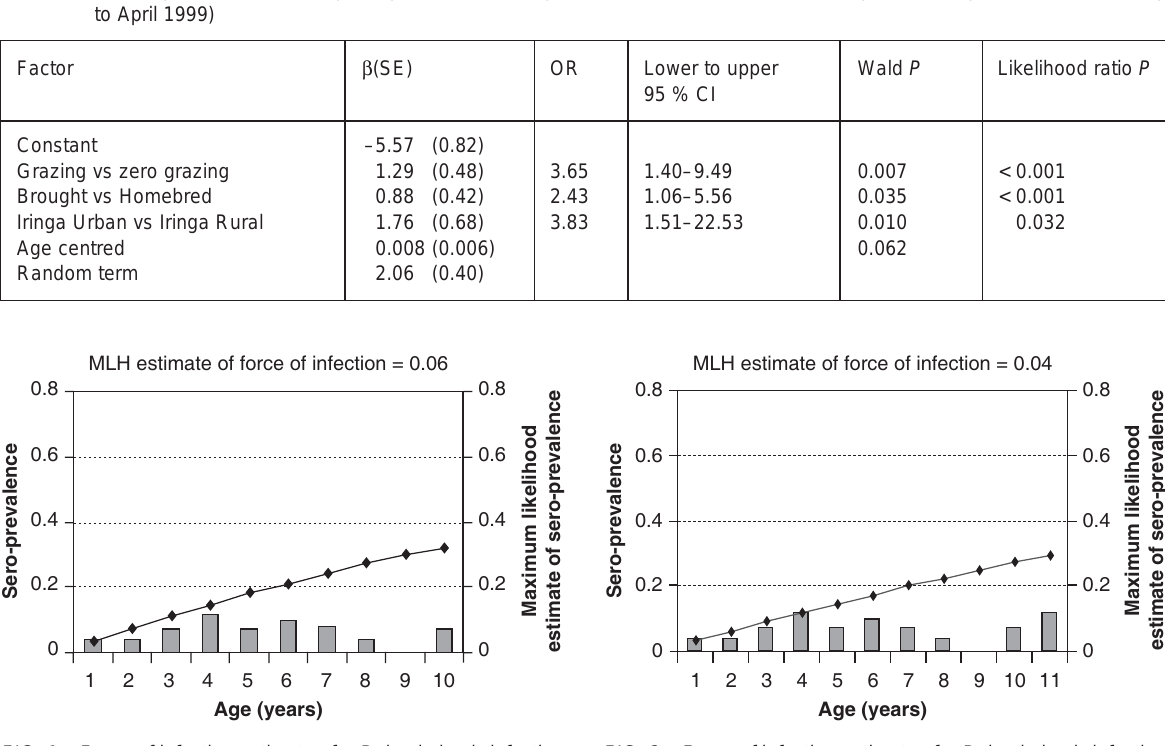
FIG. 2 Force of infection estimates for Babesia bovis infection in dairy cattle—Tanga, Tanzania (January to April